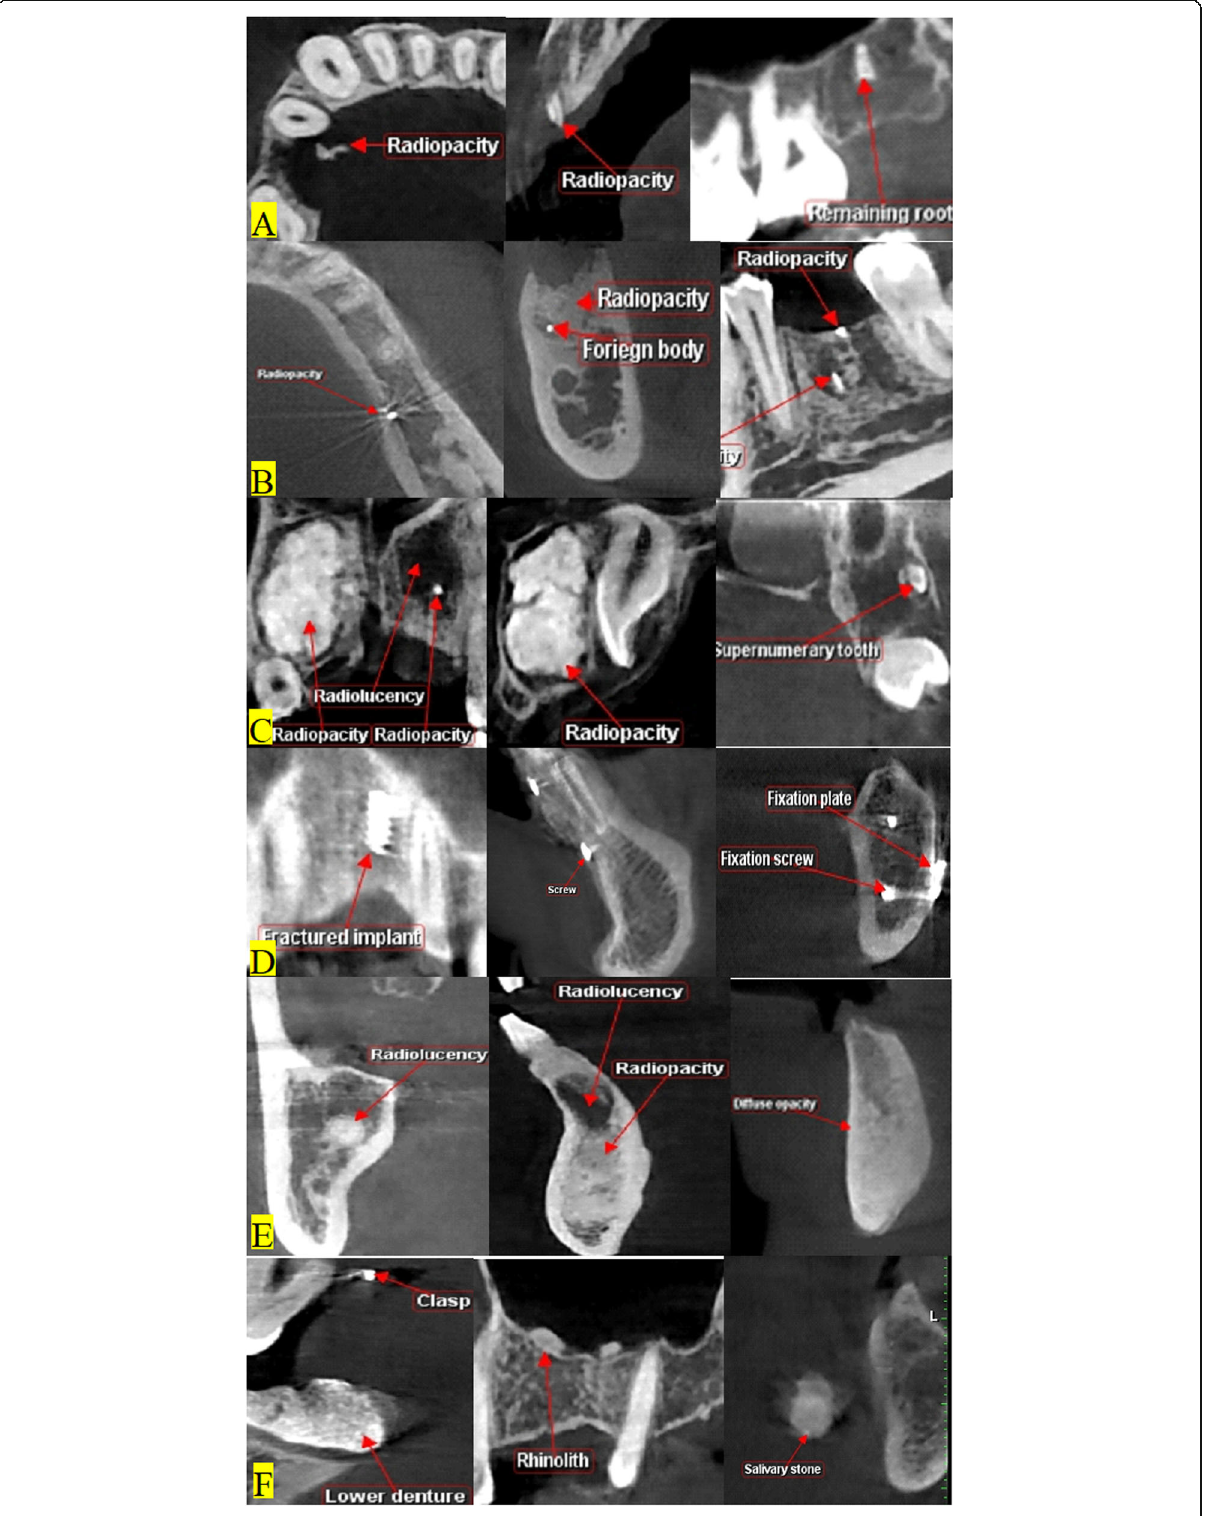
Fig. 1 (See legend on next